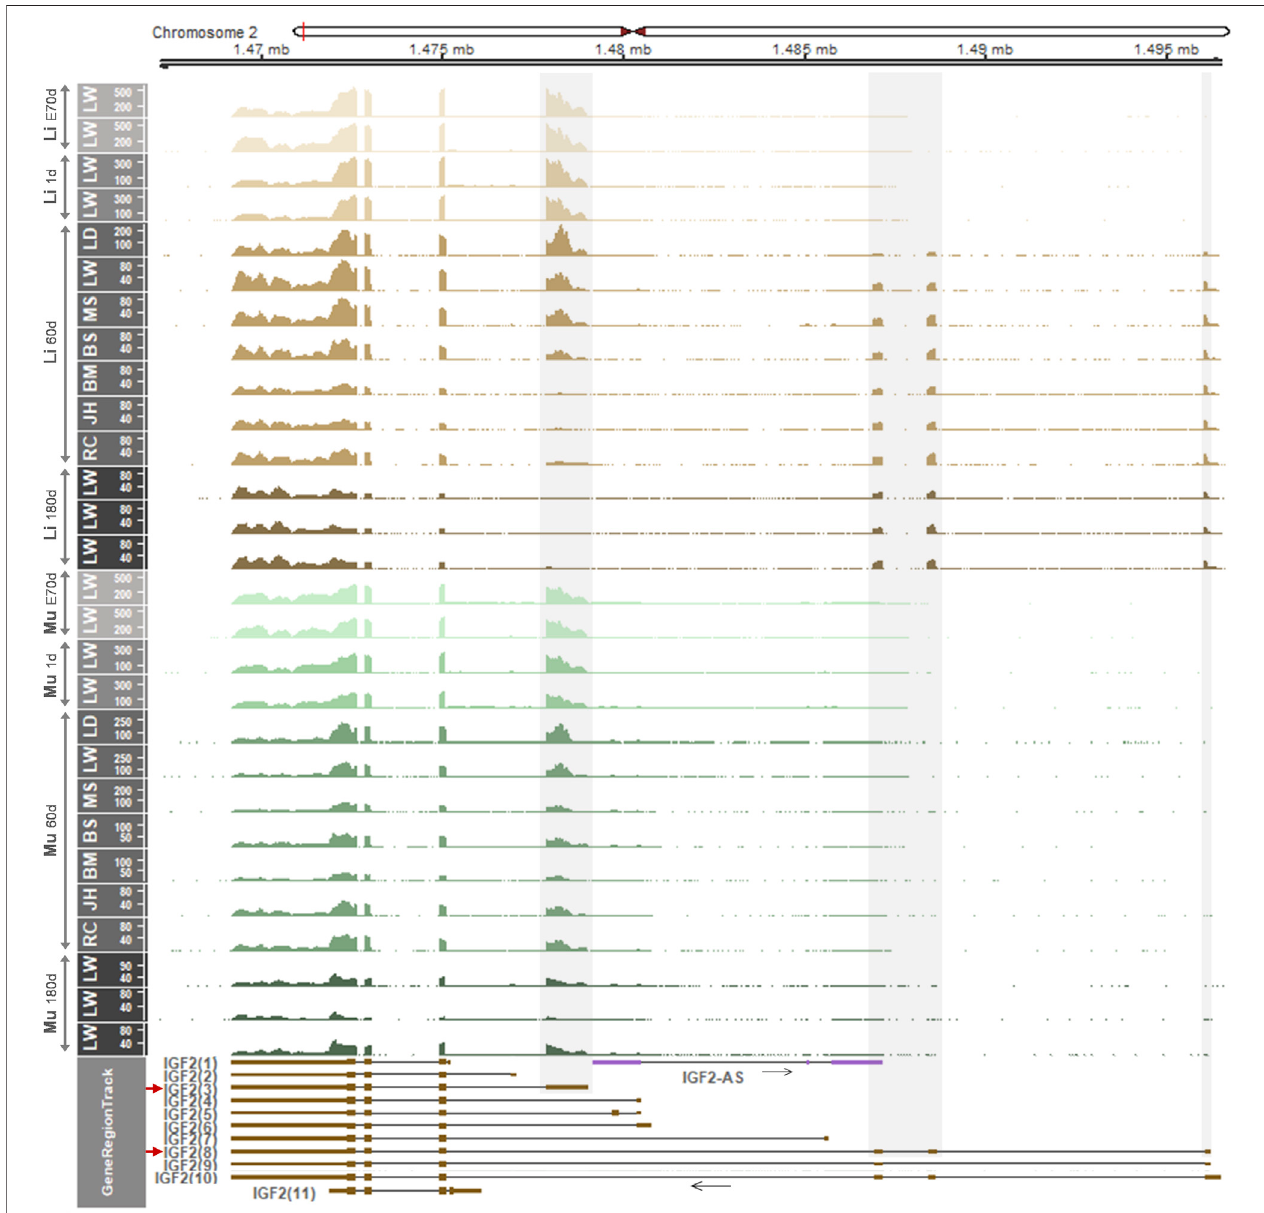
FIGURE 4 | mRNA expression in the liver and skeletal muscle within the IGF2 locus of embryonic day 70 (E70 d), 1-day-old (1 d), 60-day-old (60 d), and 180-day- old (180 d) pigs. Pig RNA-seq data generated using embryonic liver and skeletal muscle (PRJEB44486), 1 d liver and skeletal muscle (PRJEB44486), 60 d liver and skeletal muscle (GSE77776), and 180 d liver and skeletal muscle (PRJNA493166) were analyzed. Developmental stages are separated and indicated for liver and skeletalmuscleusinglightbrowntodarkbrownand lightgreentodarkgreen,respectively.Non-overlappingexonswithhighread coverages areoverlaidwithgrey shades and corresponding predominantly expressed transcripts ( IGF2(3) and IGF2(8) ) are marked by red arrows. Li, liver; Mu, skeletal muscle. LW, Large White; LD, Landrace; MS, Meishan; BS, Berkshire; BM, Bamei; JH, Jinhua; RC, Rongchang pigs.